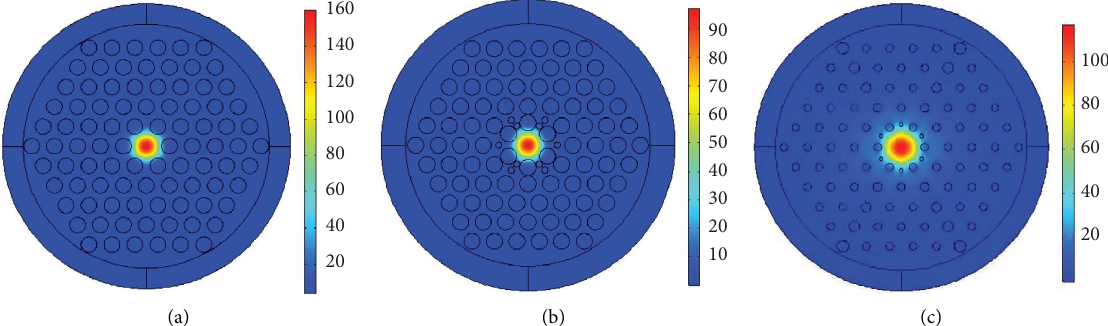
Figure 2: Te optical energy distribution in the fundamental mode’s core. (a) PCF without tiny air holes, (b) PCF with 10 tiny air holes, and (c) PCF with 6 tiny air holes, at 1.55 μ m wavelength.